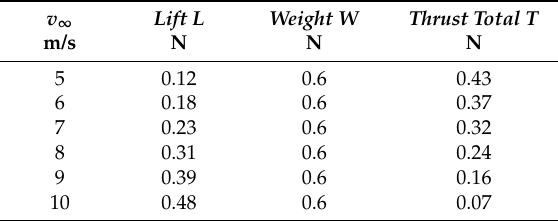
Table 1. Lift and thrust generated by a flapping bird [9].